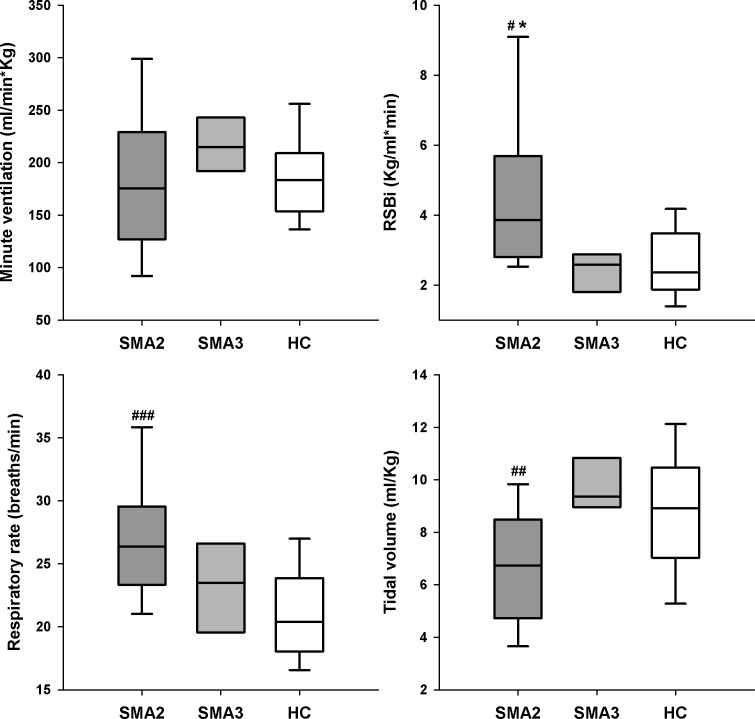
Box-and-whisker plot representing the median (line within the box), the IQR (length of the box), the 90th and the 10th percentiles (whiskers above and below the box) of minute ventilation (V´E, top left panel), rapid and shallow breathing index (RSBi, top right panel), respiratory rate (bottom left panel) and tidal volume (VT, bottom right panel) in SMA types II, III and healthy children (SMA2, SMA3 and HC, respectively) at rest during spontaneous quiet breathing in seated position.*: p<0.05 vs SMA3; #, ##, ###: p<0.05, 0.01, 0.001 vs HC